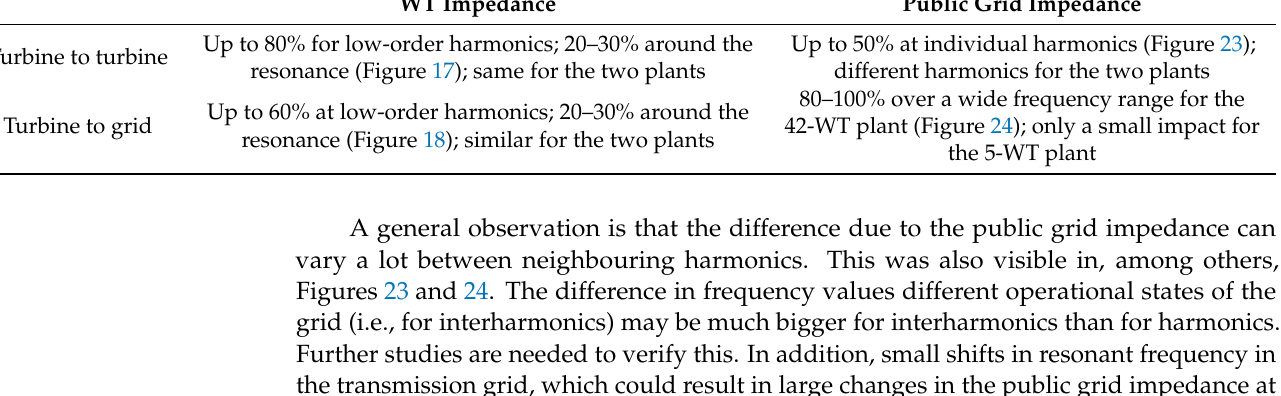
Table 3. Summary of the difference in transfer due to difference in turbine impedance and public grid impedance. WT